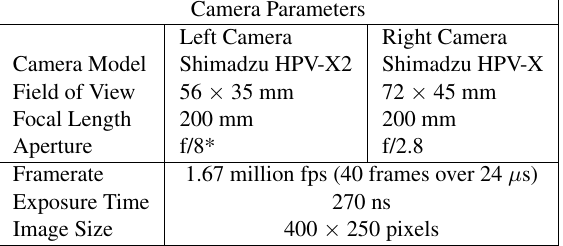
Table 2. Camera parameters used in the experiment. *approximate value, aperture not labeled